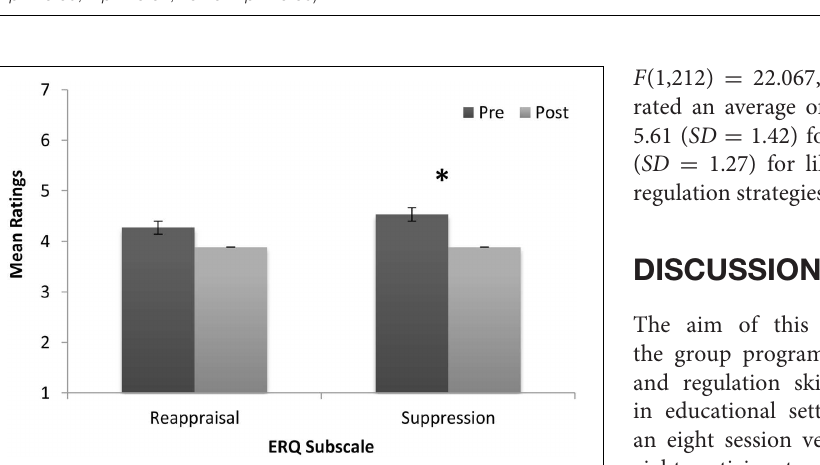
FIGURE 1 | Sample means from 41 at-risk adolescents on the emotion variables at pre- and post-program. (Bars are standard errors; significance ∗ p < 0.05, ∗∗ p < 0.01, # 0.10 > p > 0.05).